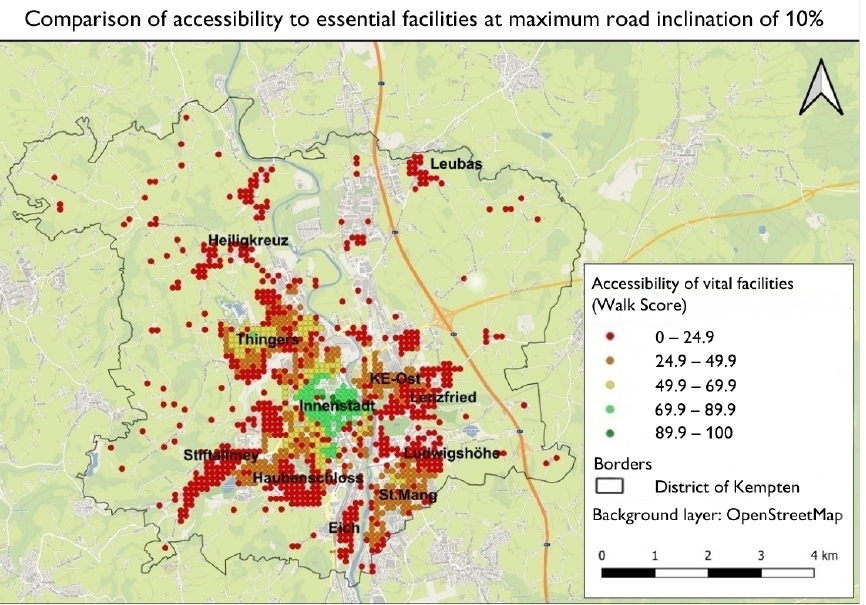
Figure 4. Walk Score map for essential supply facilities in Kempten. The categories correspond to standard WS ranges. Background map OpenStreetMap contributors.